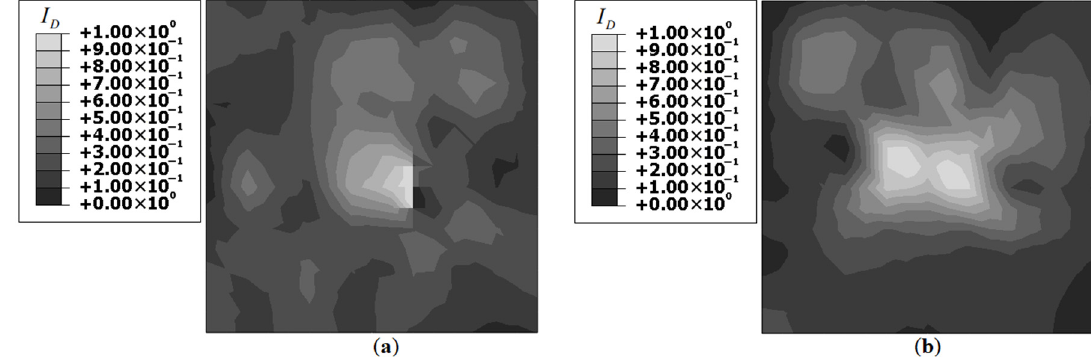
Figure 13. iFEM reconstructed I D distribution for Damage Case-1 (5% noise) using: ( a ) Unitcell-1, and ( b ) Unitcell-2.